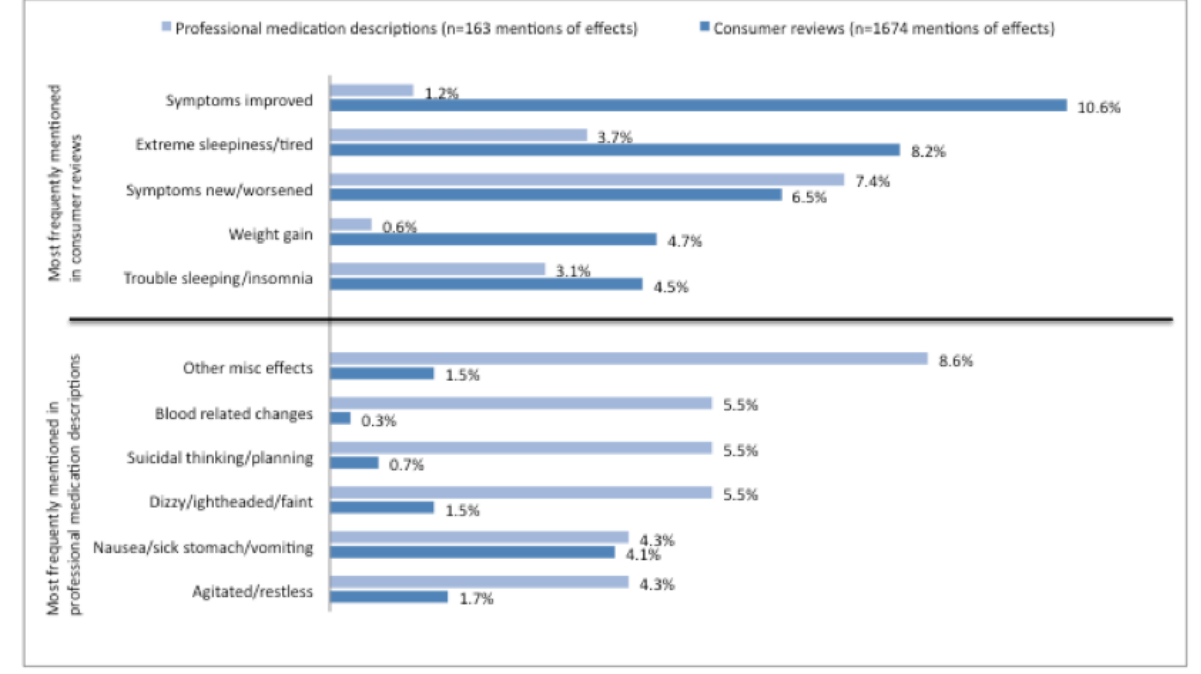
Figure 2. Most frequently mentioned effects as a proportion of all mentions of escitalopram effects in consumer-generated and in professionally controlled text